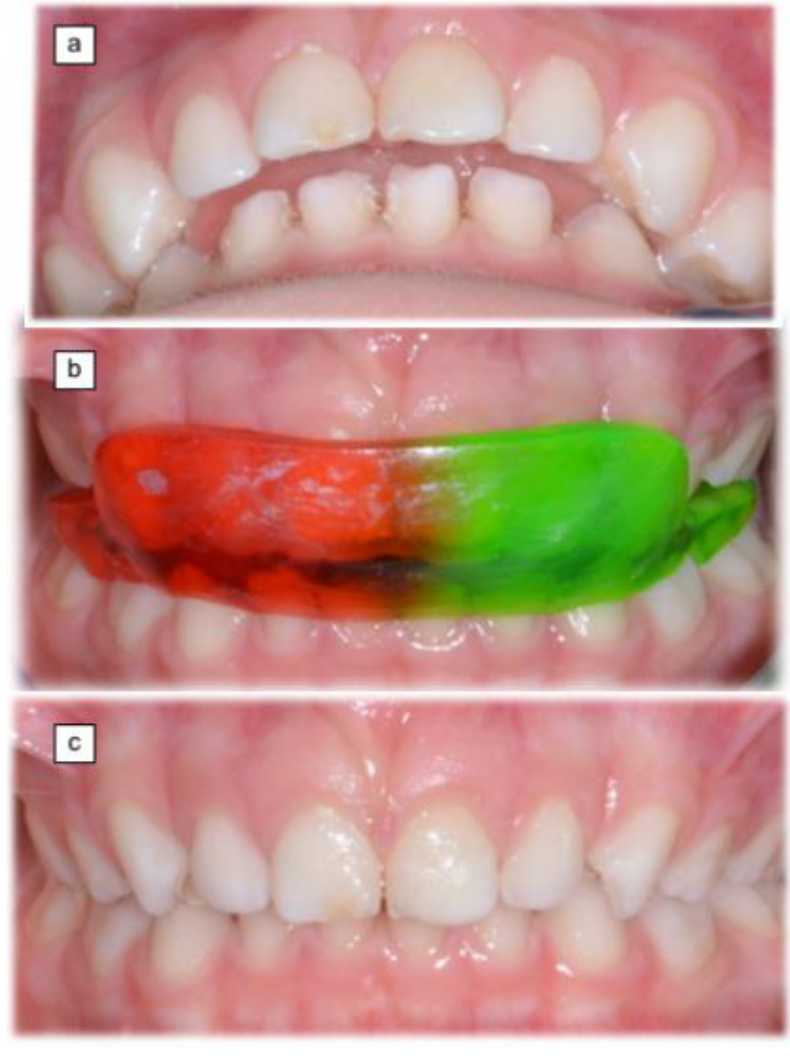
Figure 2. A 4-year child affected by rAOM and severe OSAHS (Apnea-Hypopnea Index = 10.8). ( a ) Dental malocclusion with severe overjet. ( b ) Mandibular repositioning with the oral appliance: the resolution of rAOM episodes. ( c ) Six-month result: no AOM recurrence, Apnea-Hypopnea Index = 0.4.